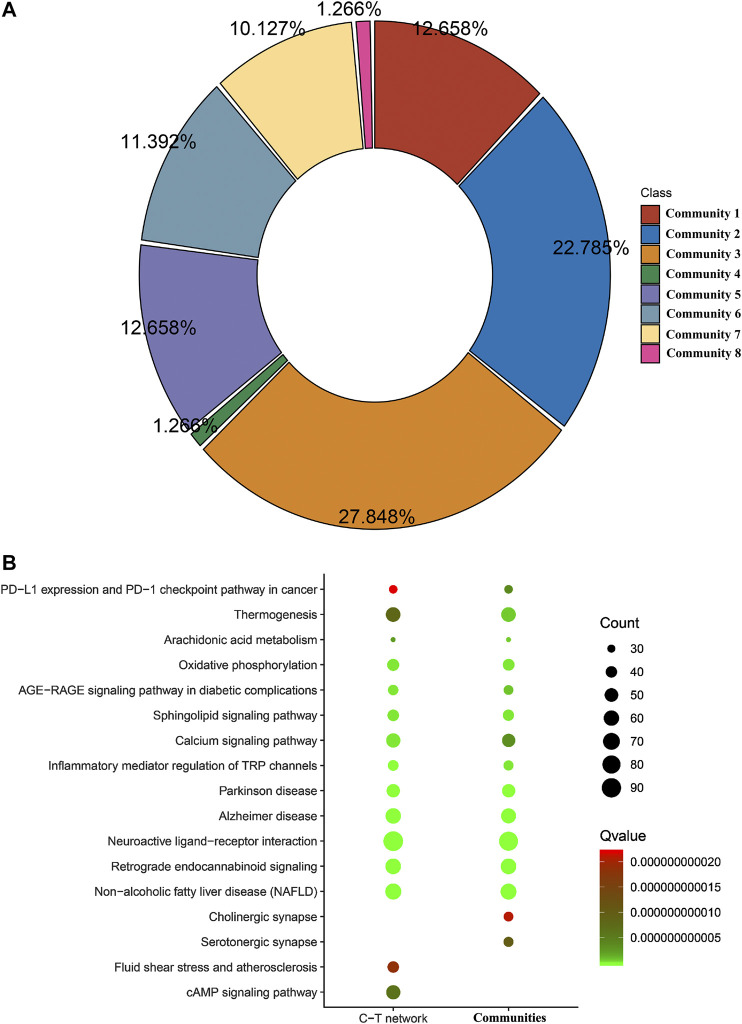
The predicated communities of C-T-P network of HJD (A). Different color represents different communities. The functional similarity analysis between C-T-P network and communities in HJD (B).